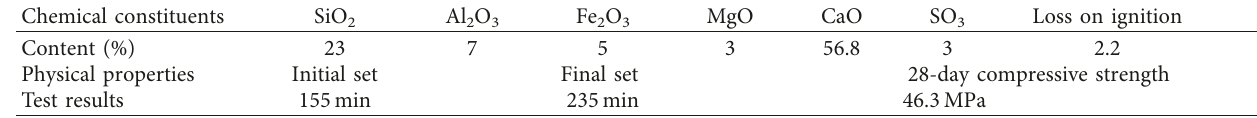
Table 1: The major chemical and physical properties of Portland cement.